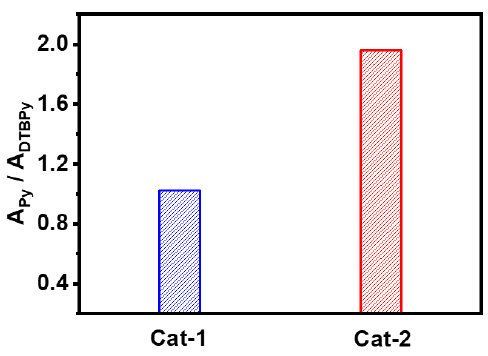
Figure 6. Acid site accessibilities of prepared FCC catalysts.